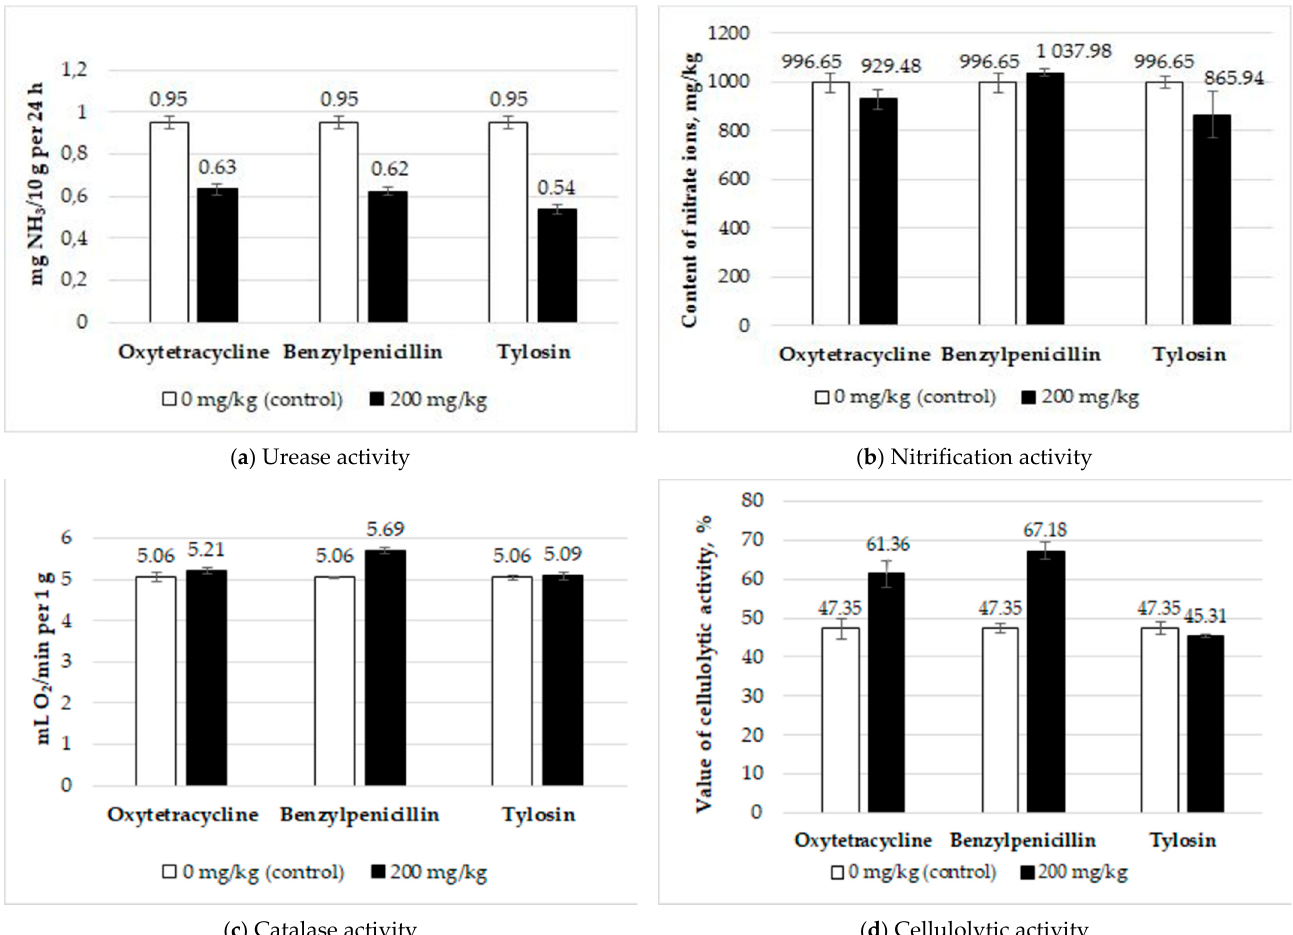
Figure 1. The amount of soil enzymatic activity in the control (0 mg/kg) and with antibiotics (200 mg/kg): ( a ) Urease activity, ( b ) Nitrification activity, ( c ) Catalase activity, ( d ) Cellulolytic activity.